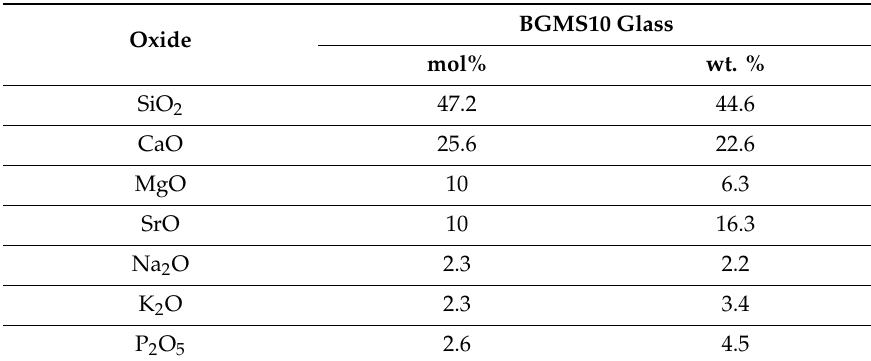
Table 1. Chemical formulation of BGMS10 bioactive